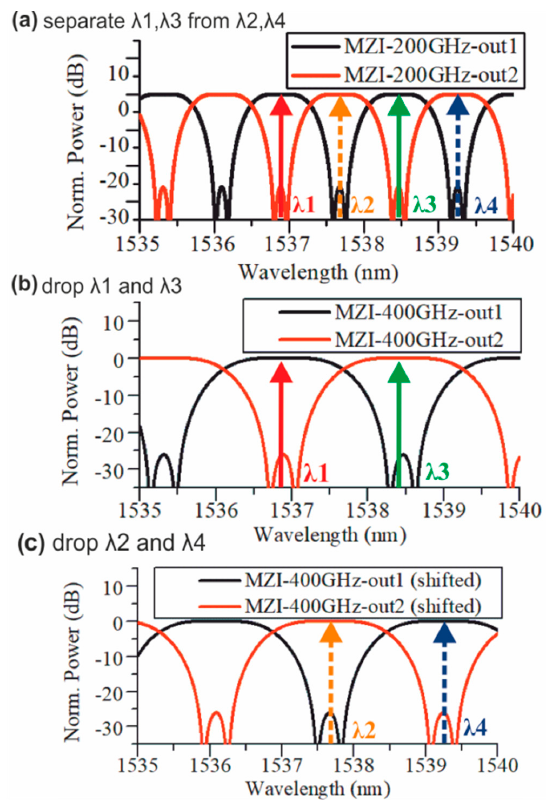
Figure 5. Simulated spectral response of the cascaded MZIs’ filters. ( a ) The filter with FSR = 200 GHz, passing λ 1 and λ 3 at its output port 1 and λ 2 and λ 4 at its output port 2. ( b ) The filter of the cascaded MZIs with FSR = 400 GHz properly phase adjusted to drop λ 1 and λ 3 , and ( c ) the filter of the cascaded MZIs with FSR = 400 GHz properly phase adjusted to drop λ 2 and λ 4 .